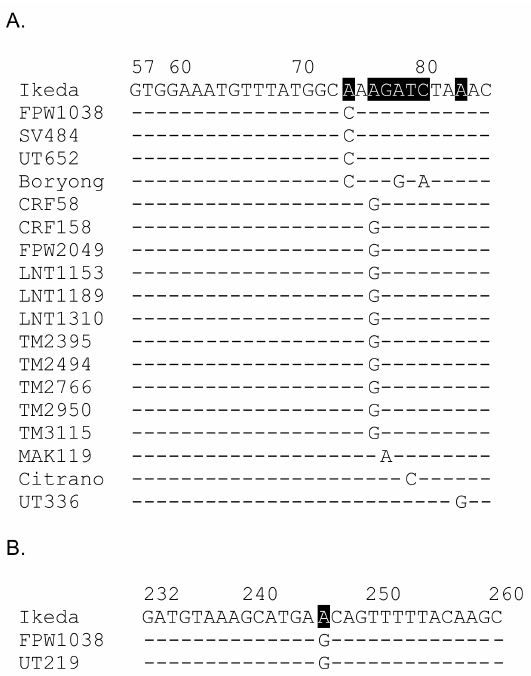
Figure 5. Nucleotide mismatches in the binding sites for ompA -57F and ompA -260R among O. tsutsugamushi isolates examined in this study. The ompA -57F ( A ) and ompA -260R ( B ) sequences, both of which correspond to O. tsutsugamushi Ikeda nucleotides, are listed. Below each are the corresponding nucleotides of where each primer would bind for any isolate in this study that has at least one mismatch. Numbers above the sequences refer to the nucleotide positions in Ikeda ompA . Dashes indicate identical nucleotides to those of ompA -57F and ompA -260R. Mismatches in the primer sequences are denoted by black-shaded white text with the specific nucleotide difference indicated per sequence